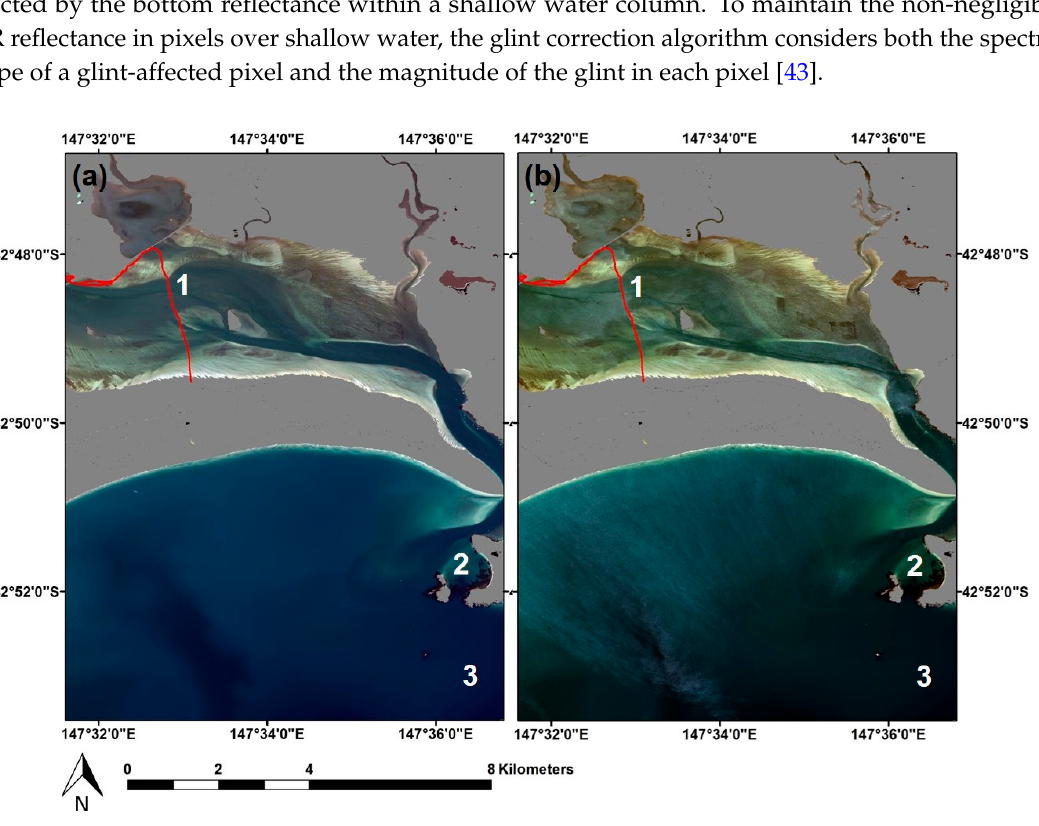
Figure 2. Subset of ( a ) Image 1 ( φ view = 106°, θ view = 77°) and ( b ) Image 2 ( φ view = 175°, θ view = 57°), acquired one minute apart on 22 October 2011 during an outgoing tide with a gentle (16 km/h) south- easterly breeze. south-easterly breeze. Gray mask: exposed land area; 1: location of the in situ depth observations atmospheric correction inter-comparison; 3: location of an as homogenous as possible area of water that is as optically deep as possible, selected for NE ∆ rsE